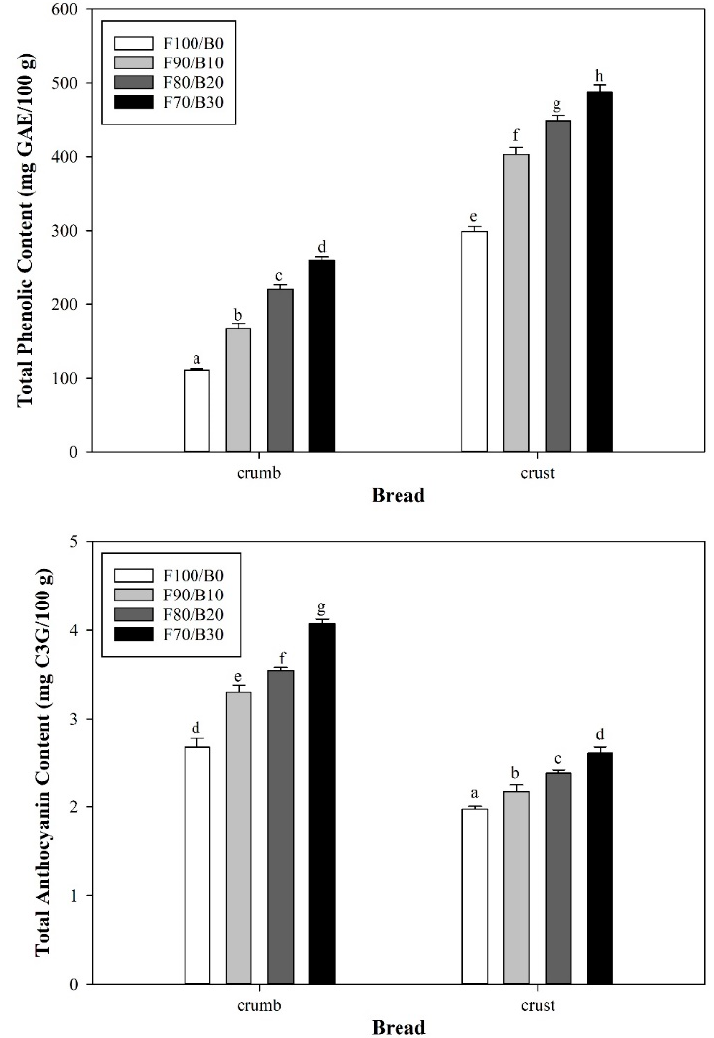
Figure 3. Total phenolic and total anthocyanin contents of the crumb and crust of the bread formu- lated with the flour–bran blends at different ratios. Bars represent the mean values, and the error bars denote the standard deviation from triplicate measurements. The same letters above the bars are not significantly different ( p < 0.05) according to Tukey’s HSD test.